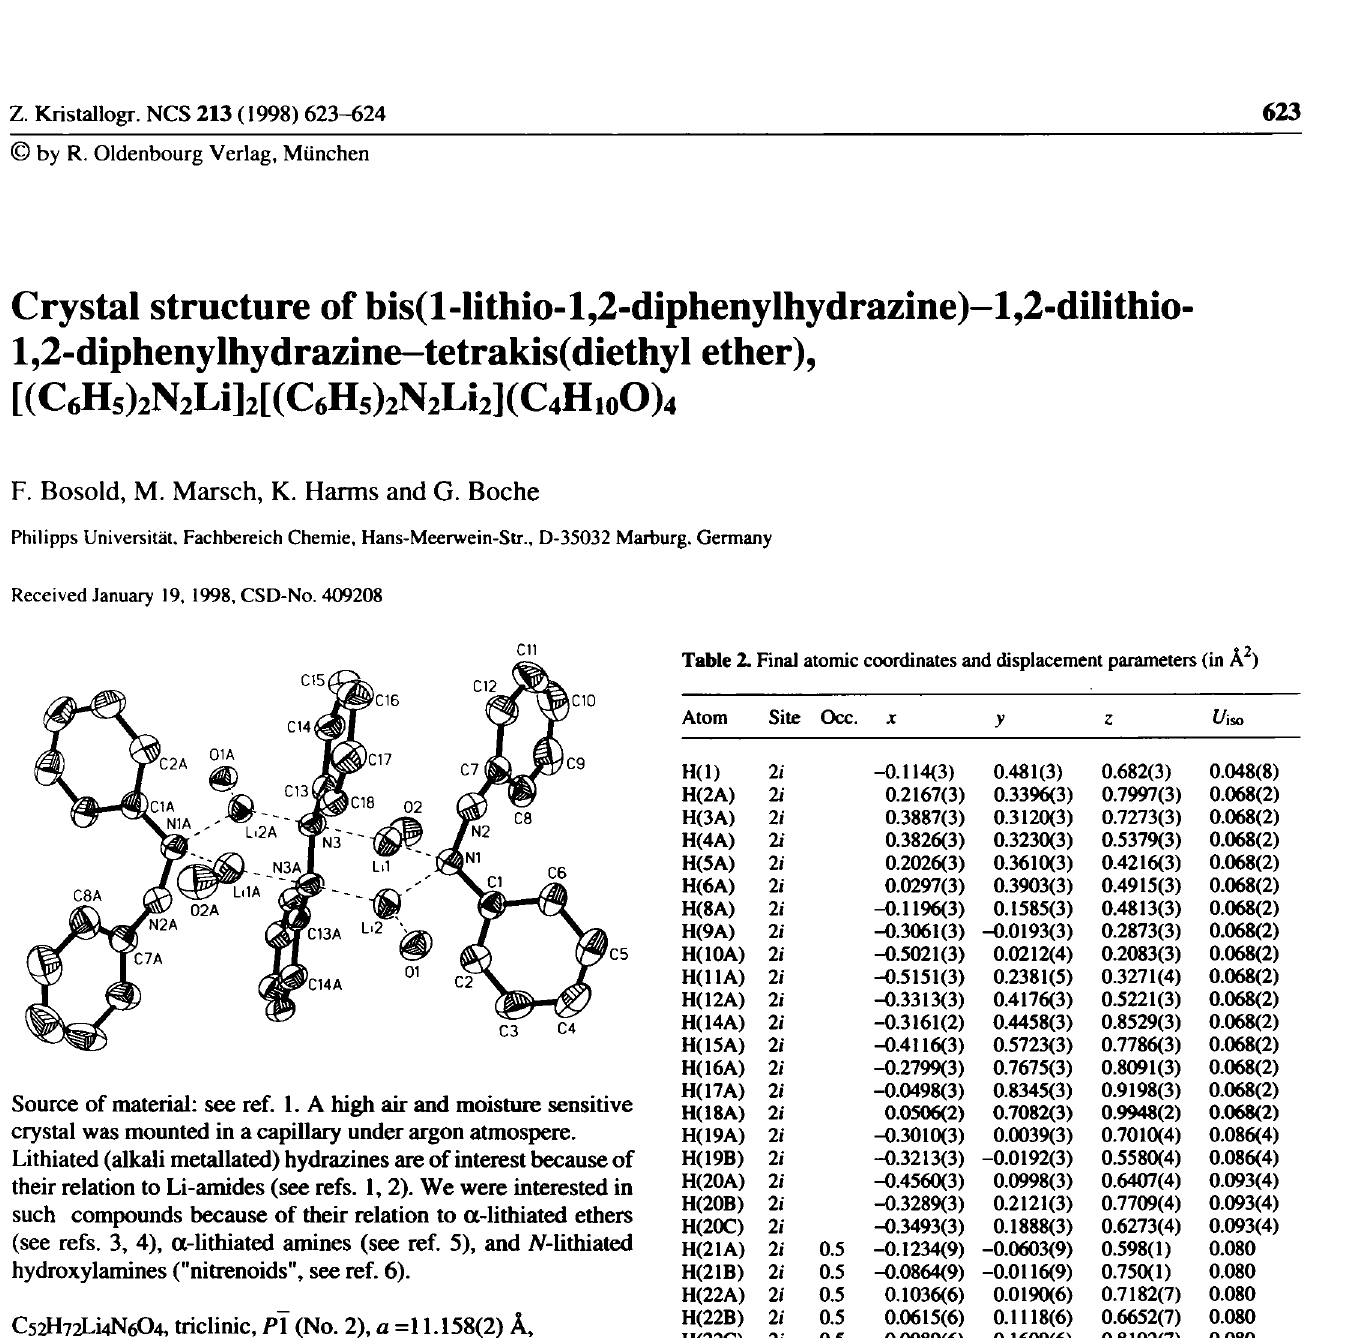
Table 1. Parameters used for the X-ray data collection Crystal: